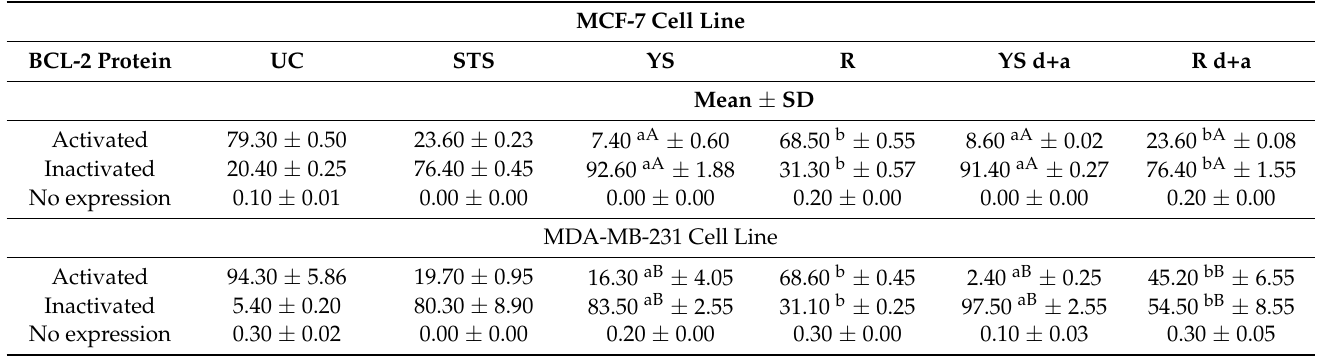
Table 5. Comparison of BCL-2 protein inactivation in cancer cells [%] using flow cytometry (Muse ® Cell